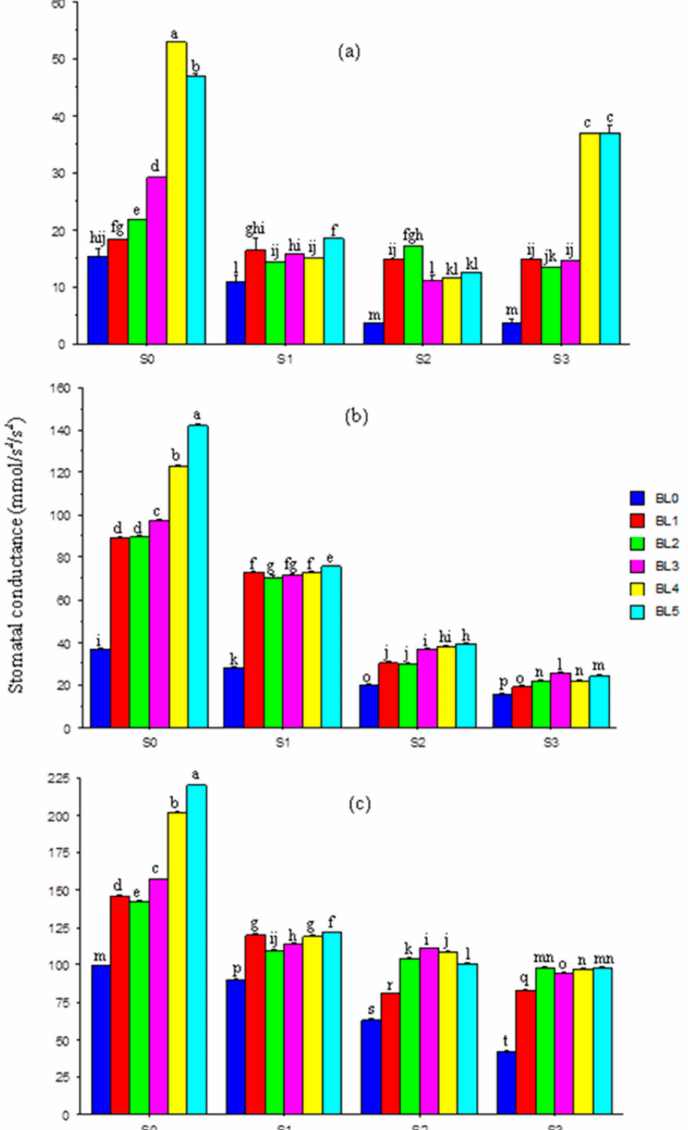
Figure 5. Interaction effects of salinity × brassinolide on stomatal conductance of soybean at 20 ( a ), 30 ( b ) and 40 ( c ) DAS. BL—brassinolide; S—salinity; DAS—days after sowing; BL0—no BL application (control); BL1—BL application at seedling; BL2—BL application at flowering; BL3—BL application at podding; BL4—BL application at seedling + flowering; BL5—BL application at seedling + flowering + podding; S0—1.10 mM/L (control); S1—32.40 mM/L; S2—60.60 mM/L; S3—86.30 mM/L.